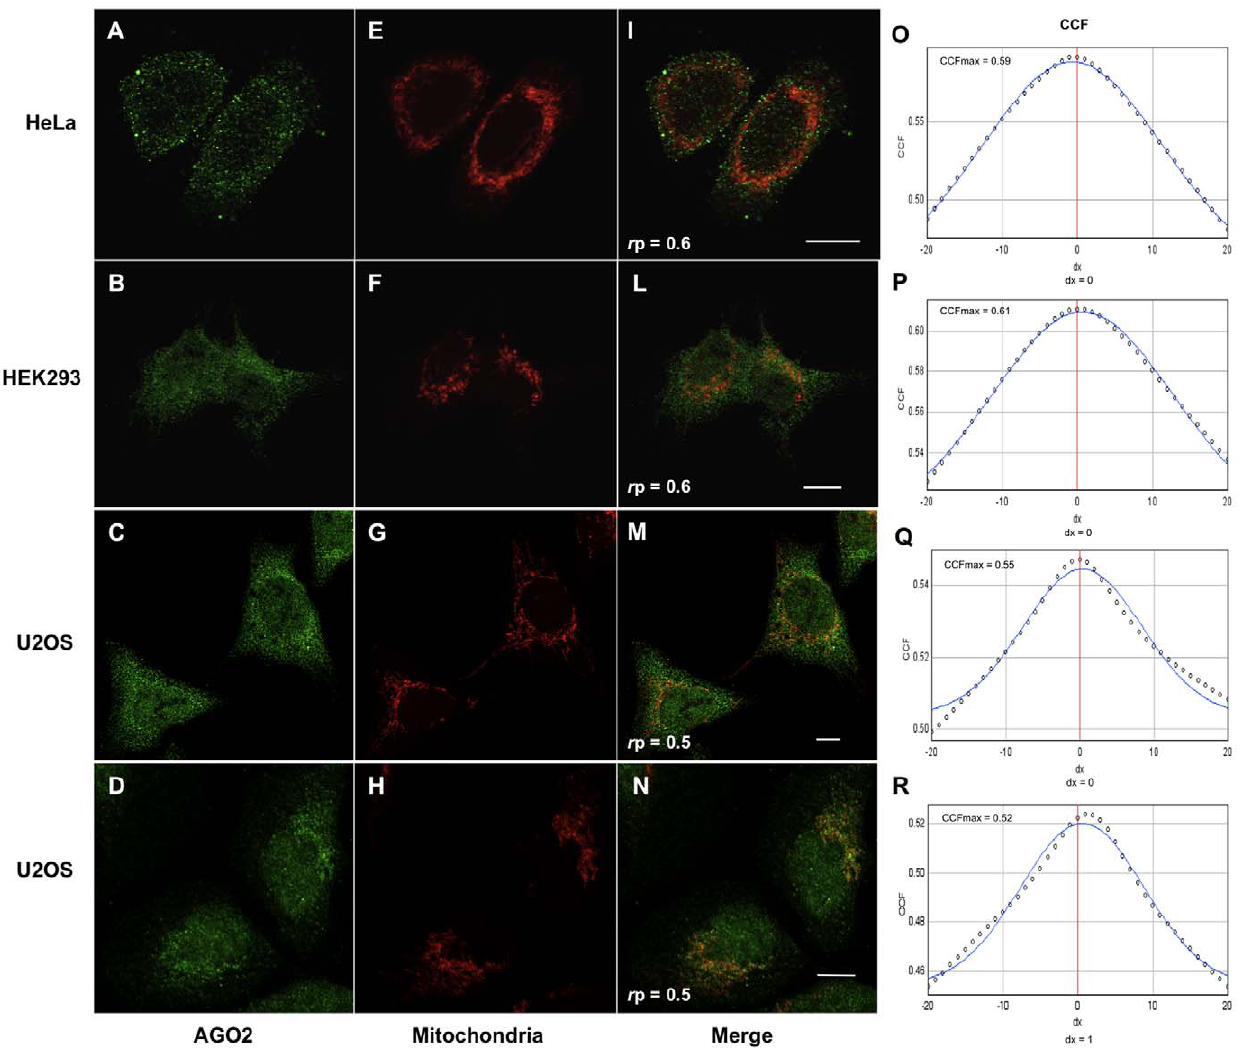
Figure 2. AGO2 protein co-localizes with mitochondria in human cell lines. Cells were fixed and endogenous AGO2 detected with two distinct antibodies (rabbit polyclonal anti-AGO2, clone 7C6, A, D; mouse-monoclonal anti-AGO2, clone 4G8, B, C) and visualized by indirect immunofluorescence. Mitochondria were either stained with Mitotracker Red CMXRos (E–G) or immunostained with anti-ATP5A1 (H). Overlay images show colocalization of AGO2 and mitochondria (I–N). A sample of 21 cells was examined for dual channel co-localization for each cell type. Co- localization was also confirmed by Pearson’s correlation coefficient ( r p), whose value is indicated at the bottom of each overlay image. Cross- correlation functions (CCFs) were calculated for each co-localization. Representative plots obtained from the analysis of a single microscopic field are shown (O–R). Maximum CCF and pixel shift (dx) values are respectively indicated at the top and the bottom of each plot. Scale bar, 10 m m.